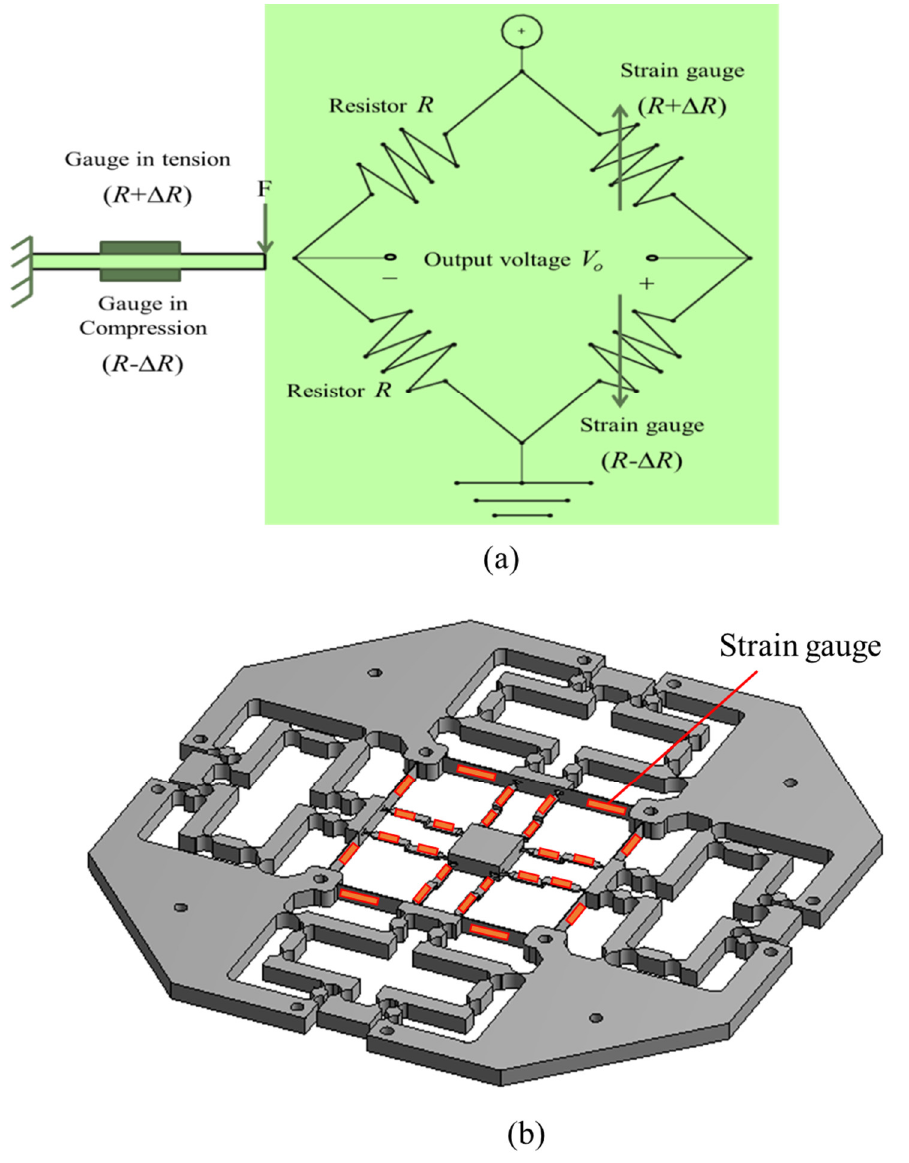
Figure 5. ( a ) Half-Wheatstone bridge circuit, and ( b ) strain gauge positions.